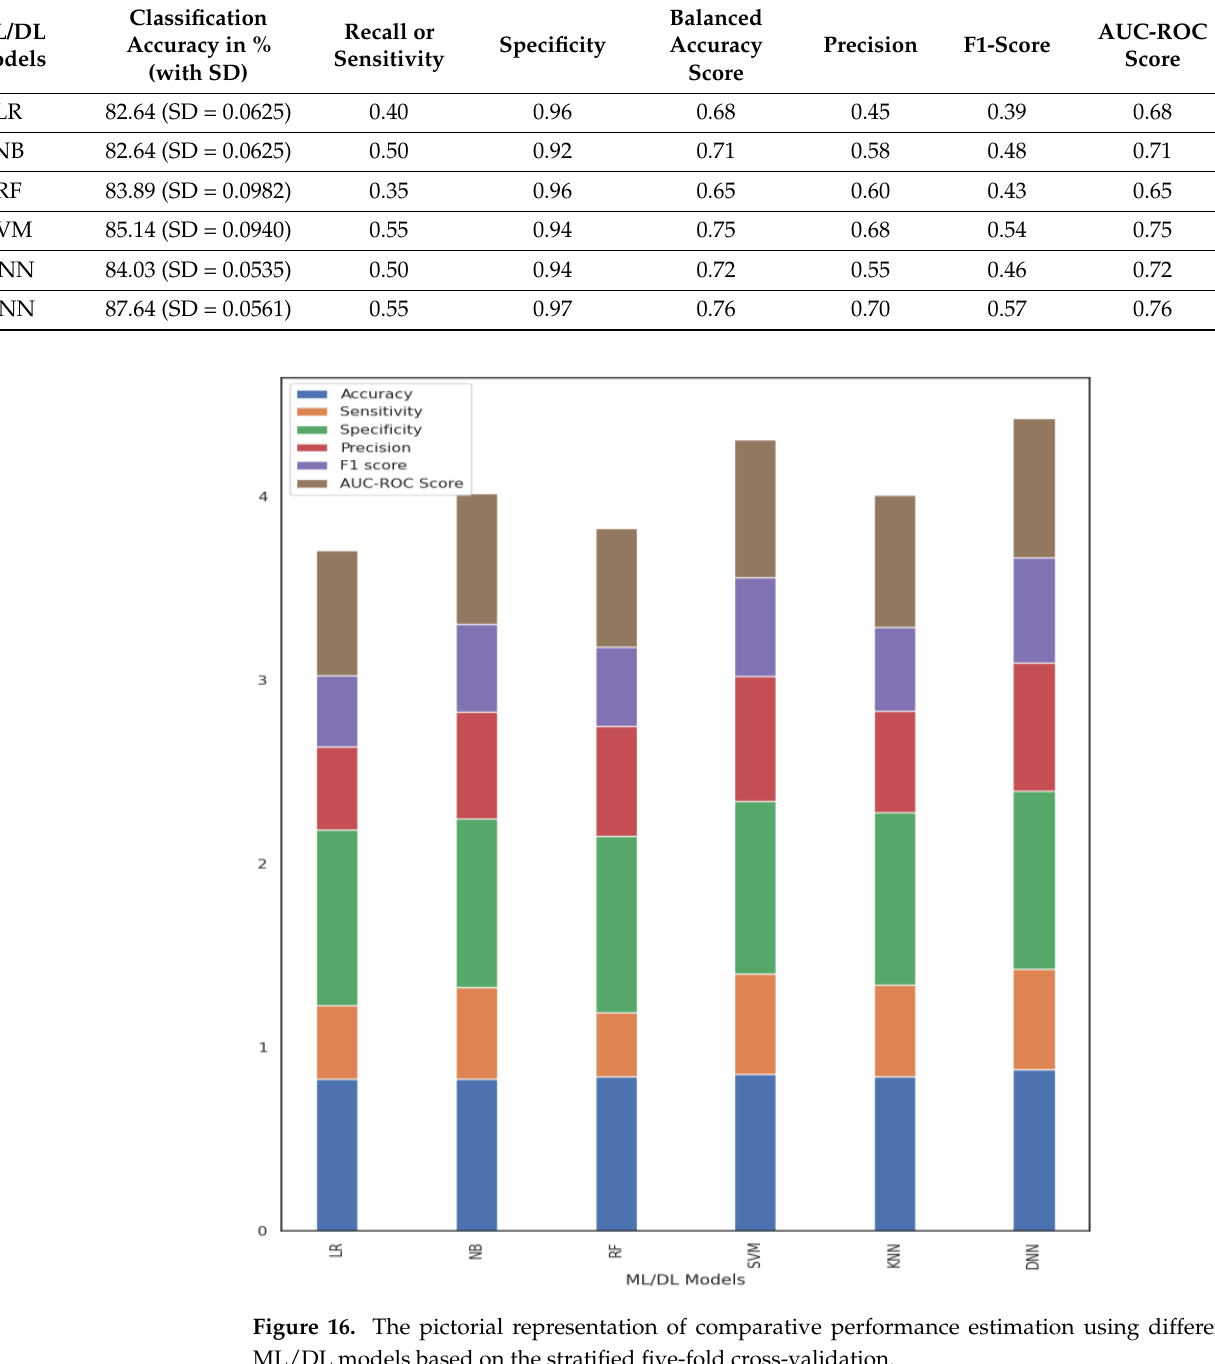
Table 4. The comparative performance estimation using different ML/DL models based on the stratified ten-fold cross-validation.